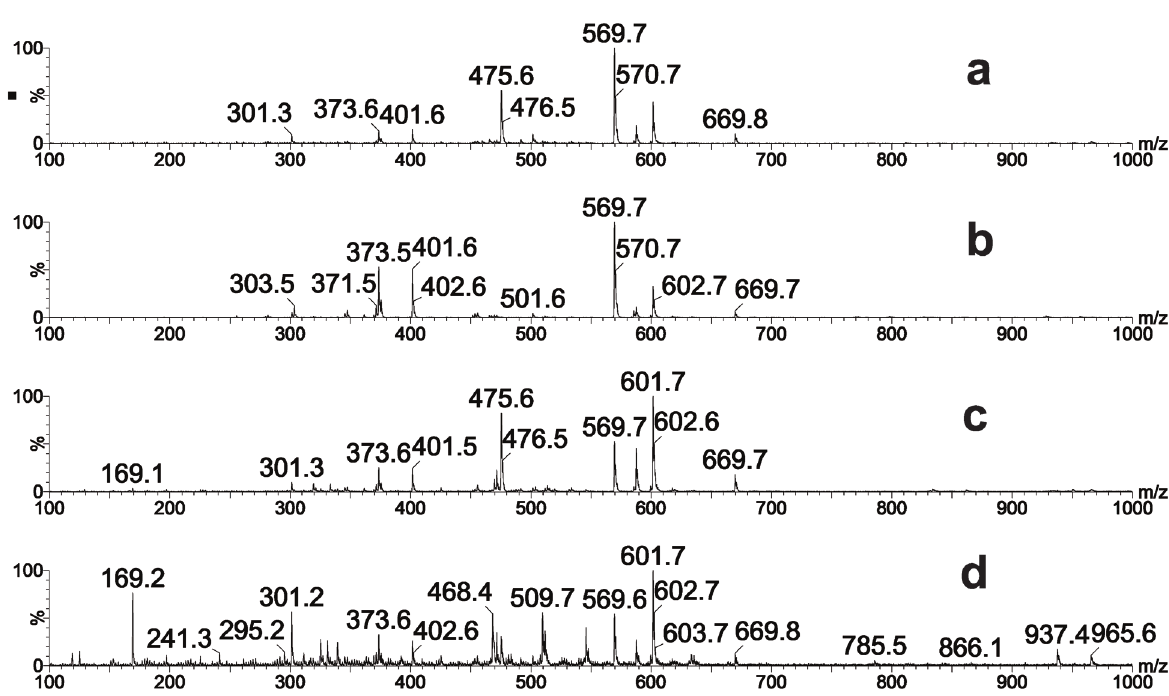
Figure 1 - ESI-MS fingerprints of M. mondury geopropolis extract and fractions determined in the negative ion mode. a ) EEGP: ethanolic extract; b ) HFGP: hexane fraction; c ) EAFGP: ethyl acetate fraction; d ) BFGP: butanol fraction.